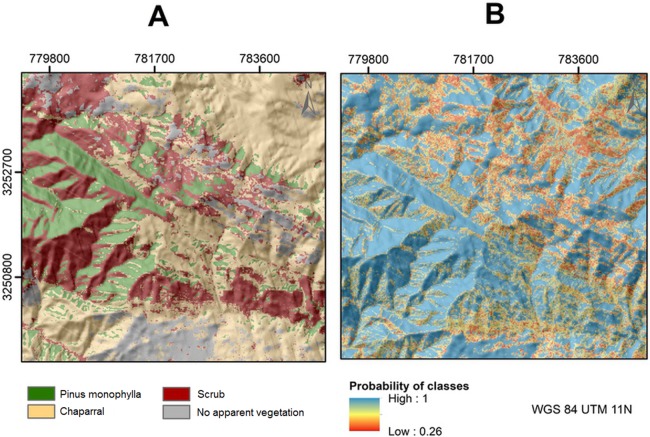
(A) Estimated land cover classes using BPNN classification in Sierra La Asamblea. (B) Probability map of class assignment.